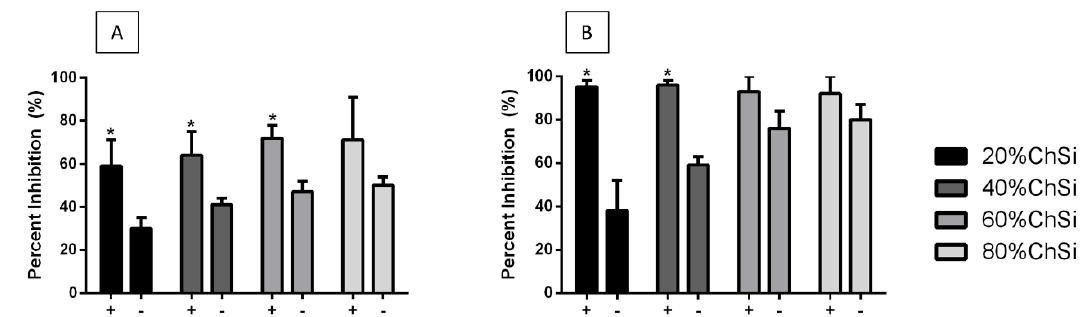
Figure 14. Inhibition of bacterial biofilm formation on hybrid coatings with ( + ) and without ( − ) AgNPs. ( A ) E. coli and ( B ) S. aureus biofilm formation (24 h) were inhibited on all hybrid coatings, compared to uncoated titanium (Ti6Al4V) controls. Inhibition of biofilm formation was greater on coatings that contained AgNPs and was generally more on coatings with higher organic content. There was near complete inhibition of S. aureus biofilms on all hybrid coatings that contained AgNPs.